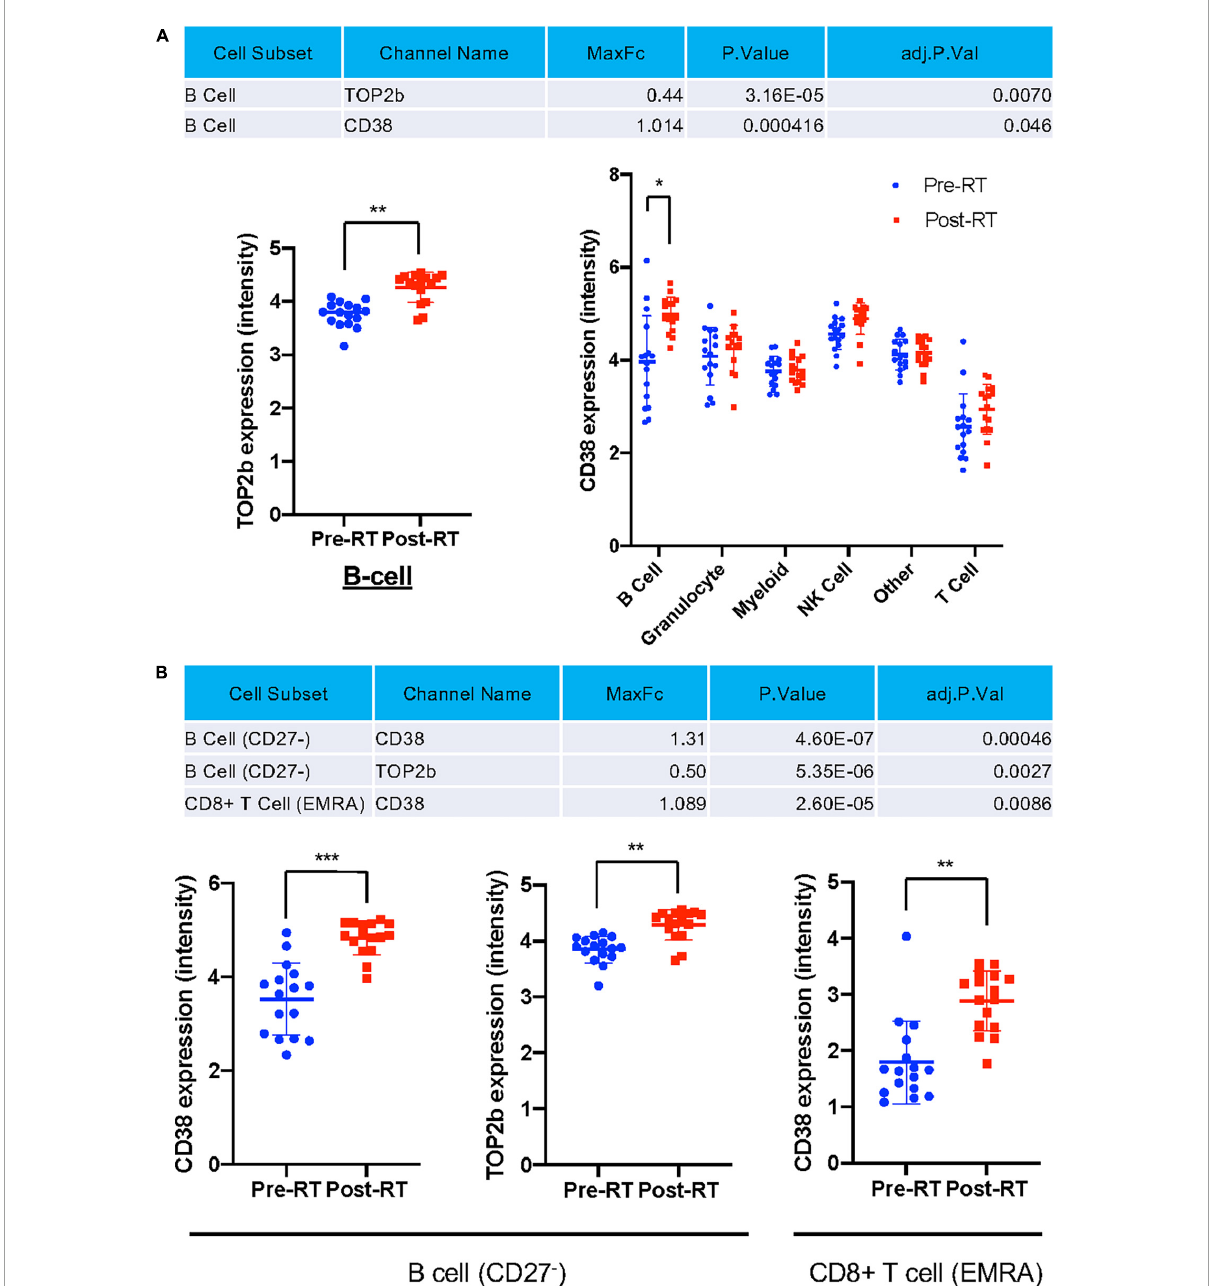
FIGURE5 Only TOP2b and CD38 expression were significantly increased after RT at the cell subset level. (A) Only TOP2b and CD38 expression in B cells were increased after RT, and no significant change of studied molecules in cell types after RT compared to pre-RT level was observed. (B) CD38 and TOP2b expression in B cell (CD27 − ) and CD8 + T EMRA subset pre- and post-RT. Mean ± SD, *adj. P -Val < 0.05, **adj. P -Val < 0.01, ***adj. P -Val <